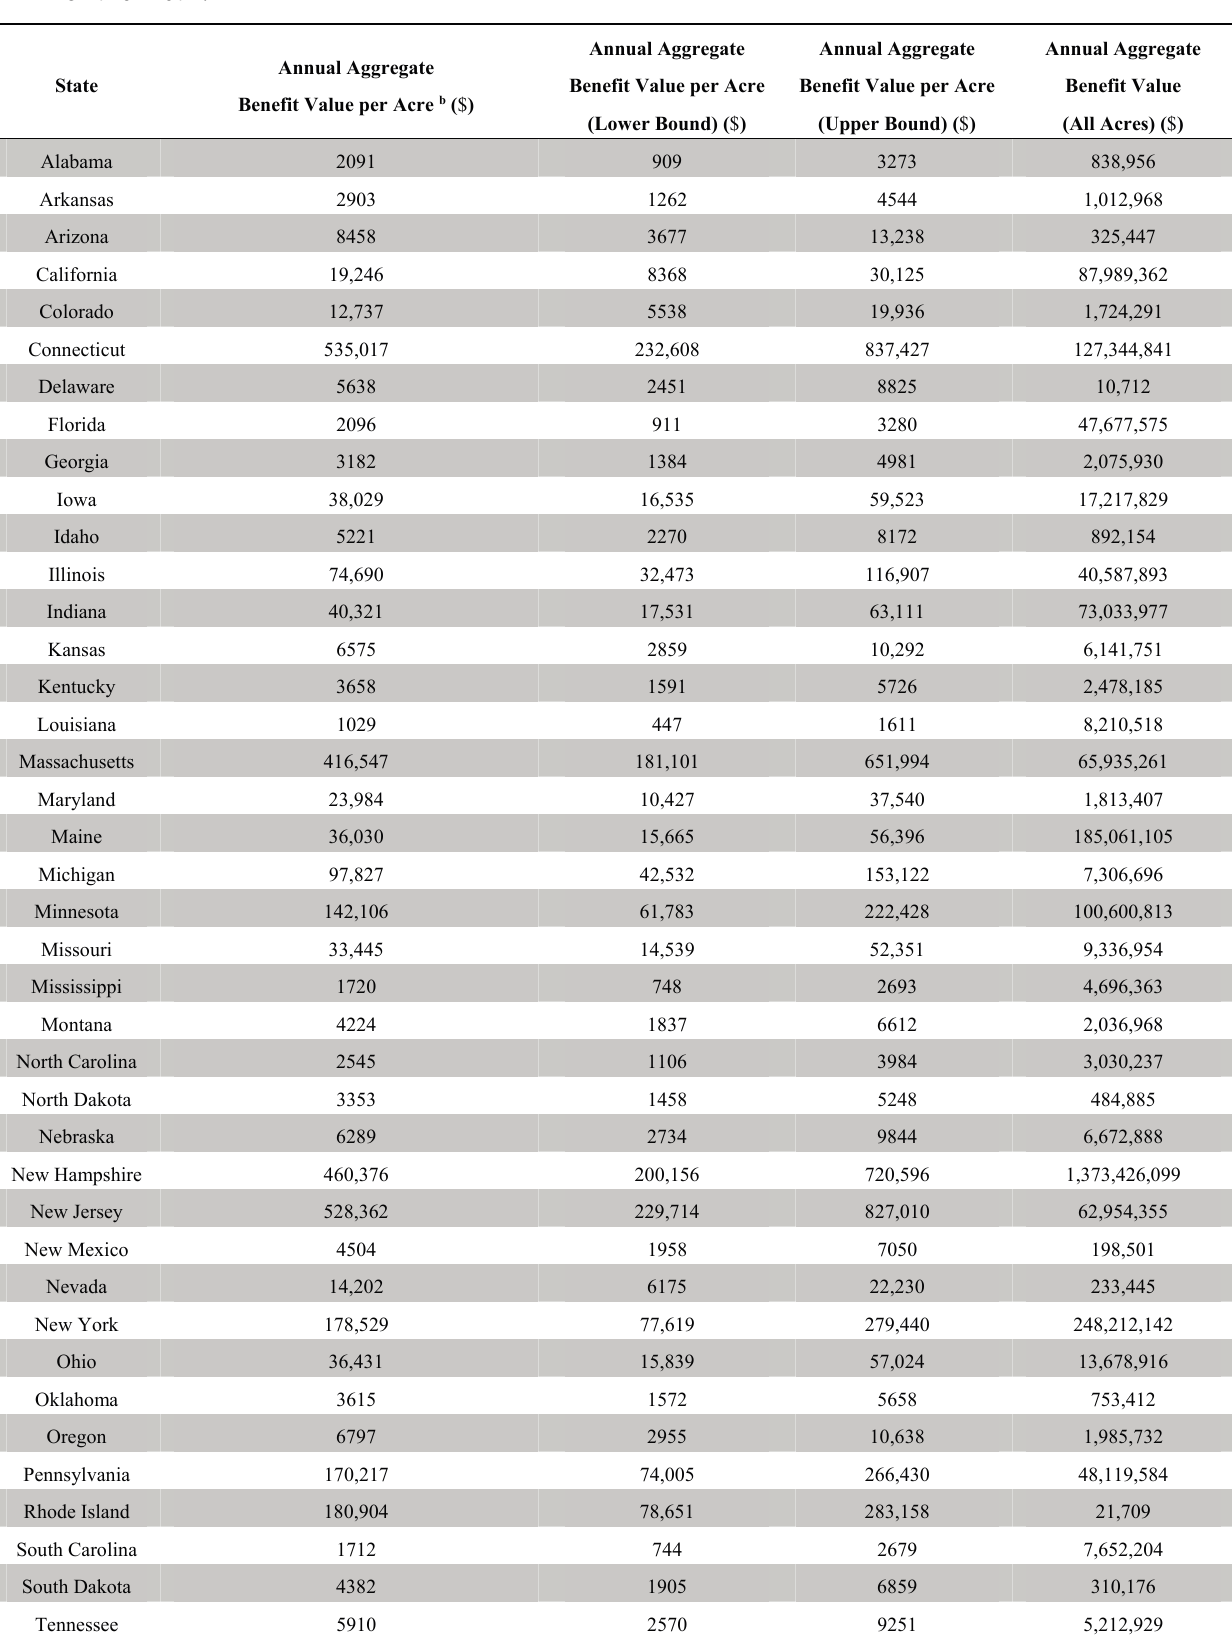
Table 4. Statewide annual aggregate benefit values, their lower and upper bound estimates, and annual value of total wetland mitigation acres in the continental U.S. under Section 404 of the Act a